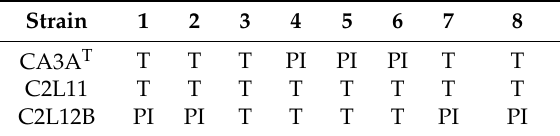
Table 5. Antagonism test of P. typographi strains against the entomopathogen fungi: Lecanicillium